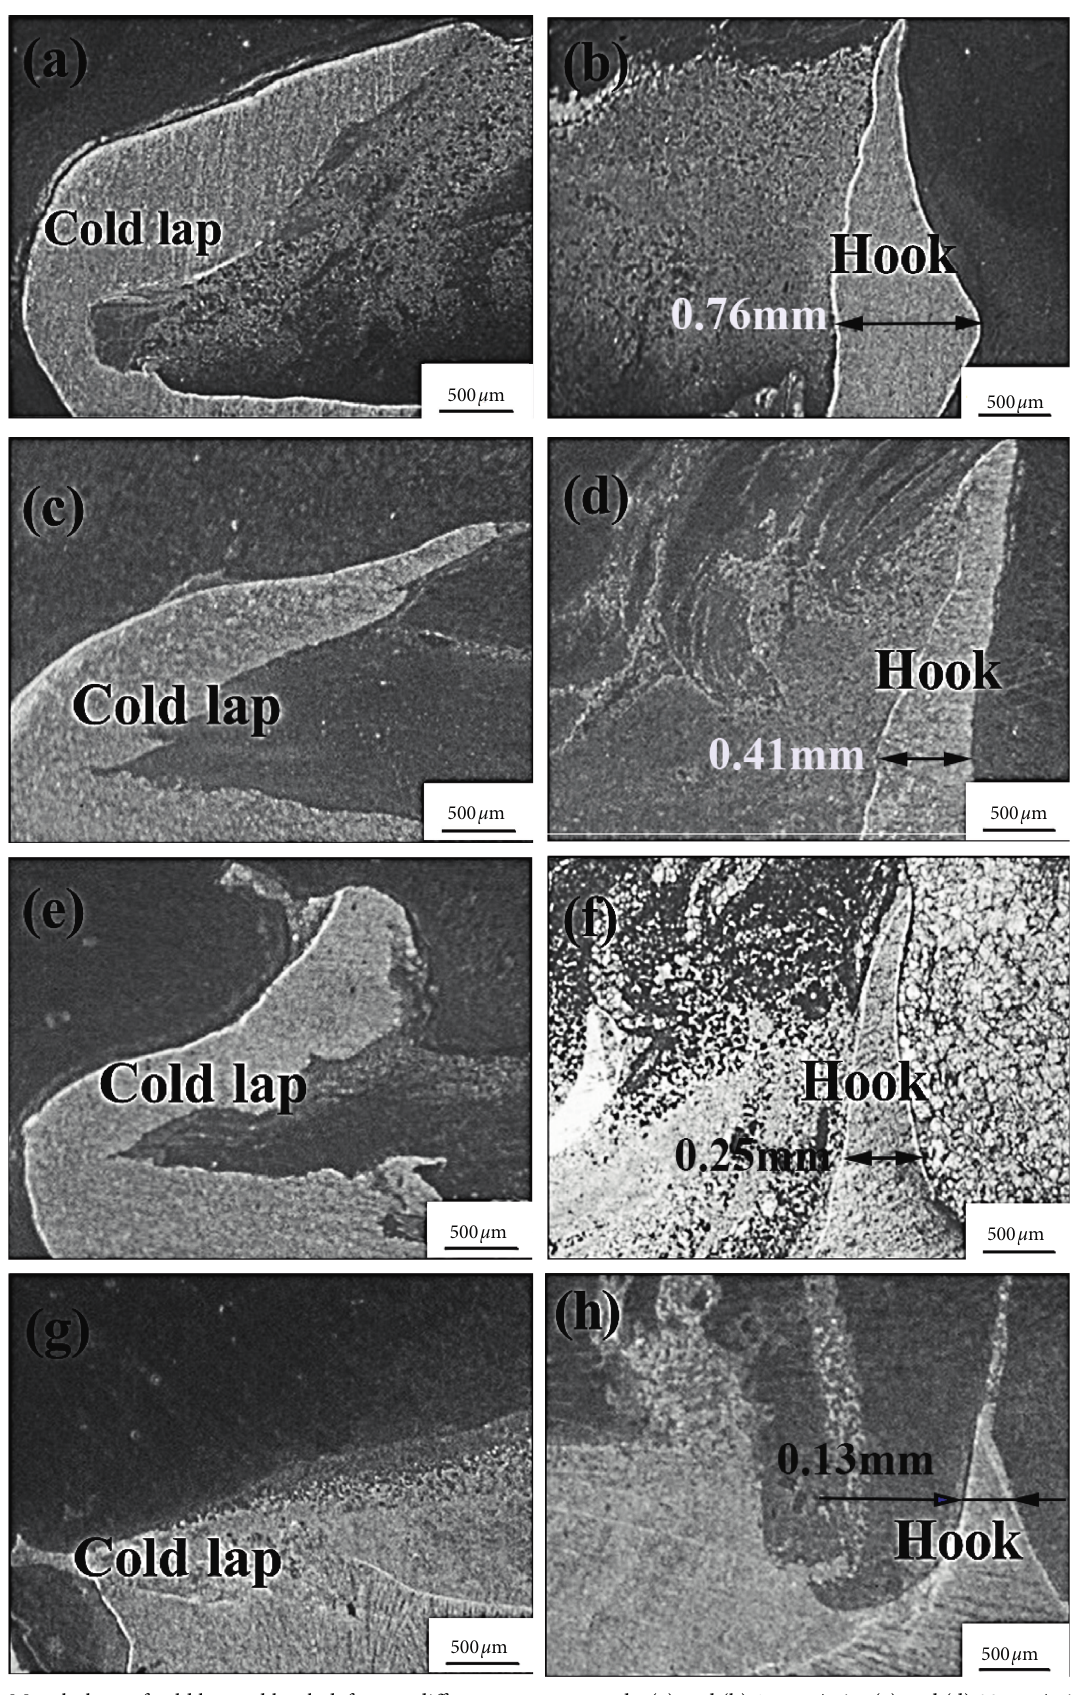
Figure 9: Morphology of cold lap and hook defects at different traverse speeds: (a) and (b) 15 mm/min; (c) and (d) 30 mm/min; (e) and (f) 50 mm/min; (g) and (h) 65